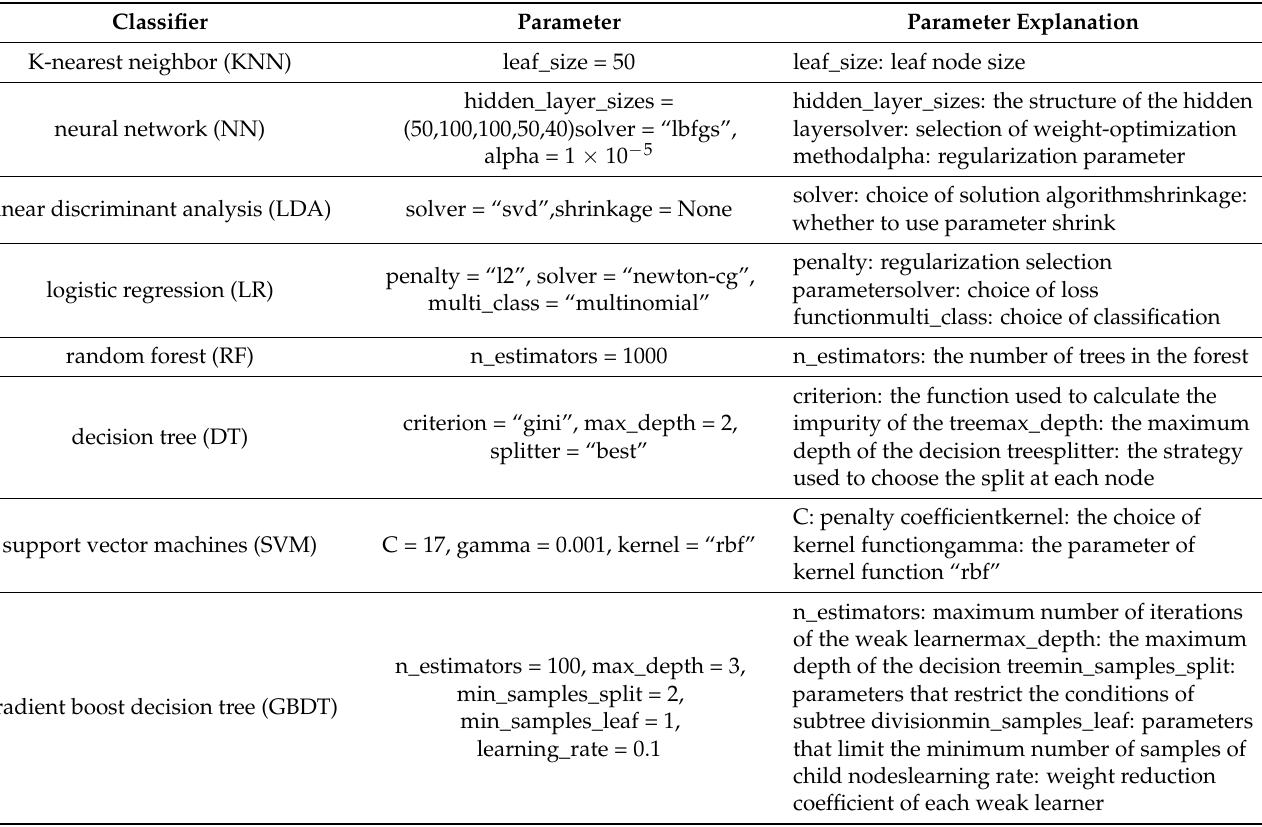
Table 3. Hyperparameter Settings of Classification Algorithms (the settings of other parameters follow the default settings of sklearn if not